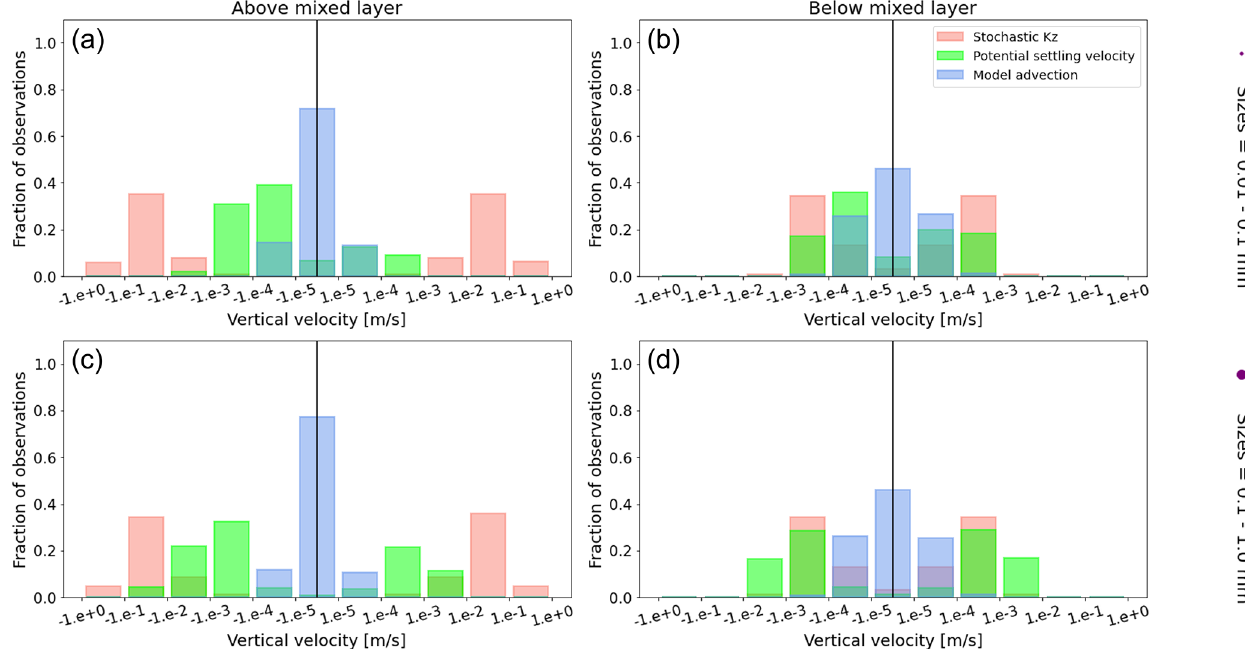
Figure A3. As in Fig. A1 but for the Southern Ocean.